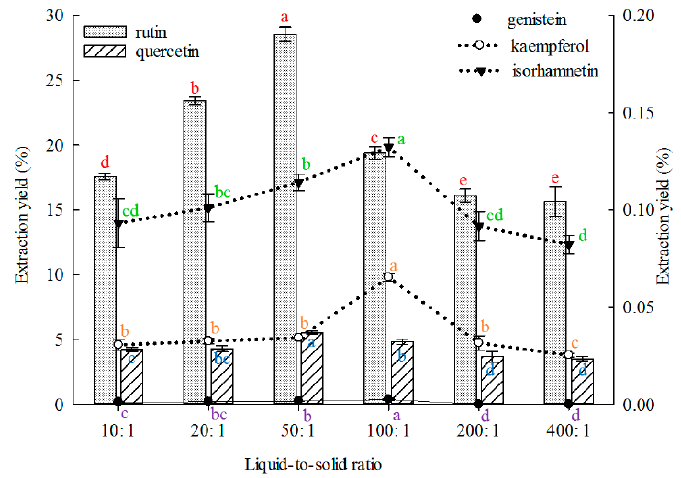
Figure 4. Effects of liquid-to-solid ratio on the extraction yields of the five constituents (the bar and lines graphs are referenced to the left and right axes, respectively; different letters stand for significant difference at 5% level).